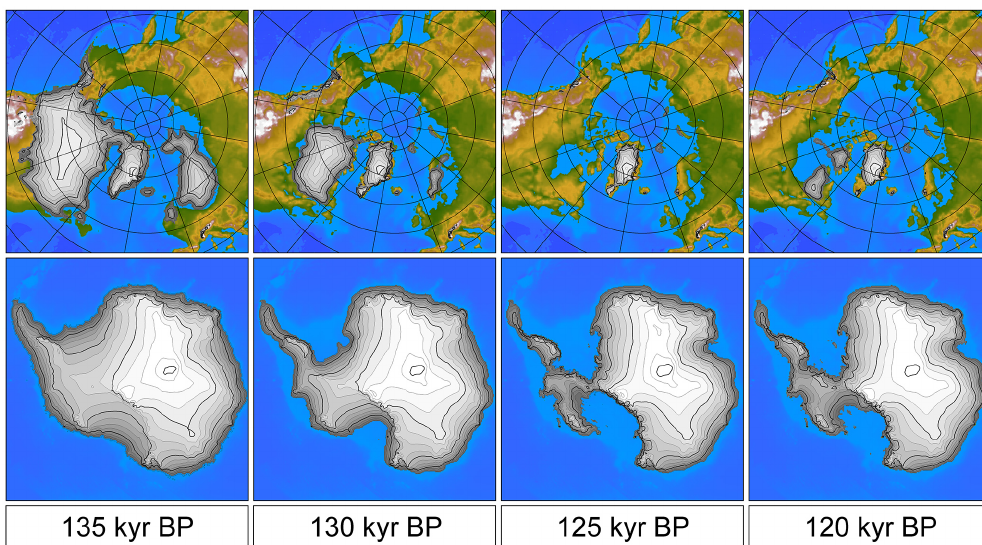
Figure 2. Evolution of reconstructed Northern Hemisphere ice sheets and embedded modelled GrIS (top) and modelled AIS (bottom) used as boundary conditions for the climate